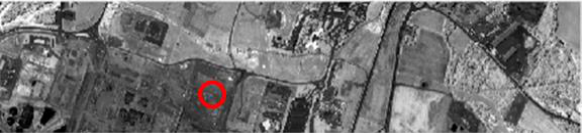
Figure 3 . Hyperspectral radiance image acquired with HySpex- NEO camera and plotted at 967 nm. The circle represents the emission point.